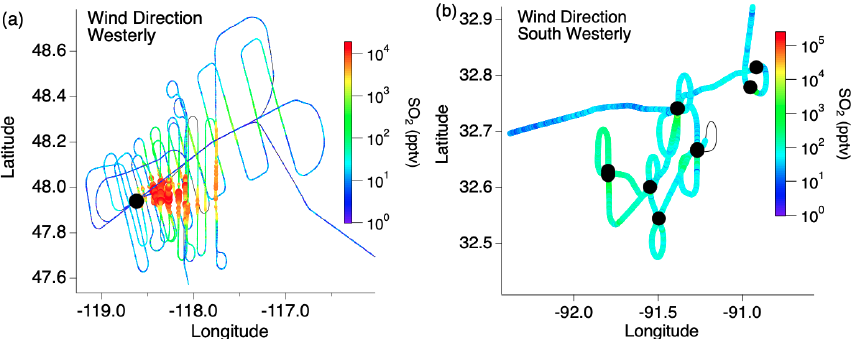
Figure 1. Typical flight path through (a) wildfire and (b) agricultural fire smoke plumes with the color and size of the markers indicating the SO 2 mixing ratio and the black markers indicating the fire